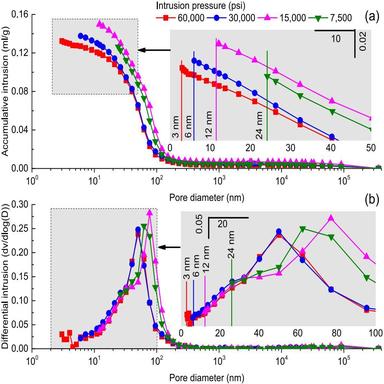
Intrusion PSDs of the HCP samples with different maximum applied pressures: (a) APSD and (b) DPSD curves of the P-05 samples.